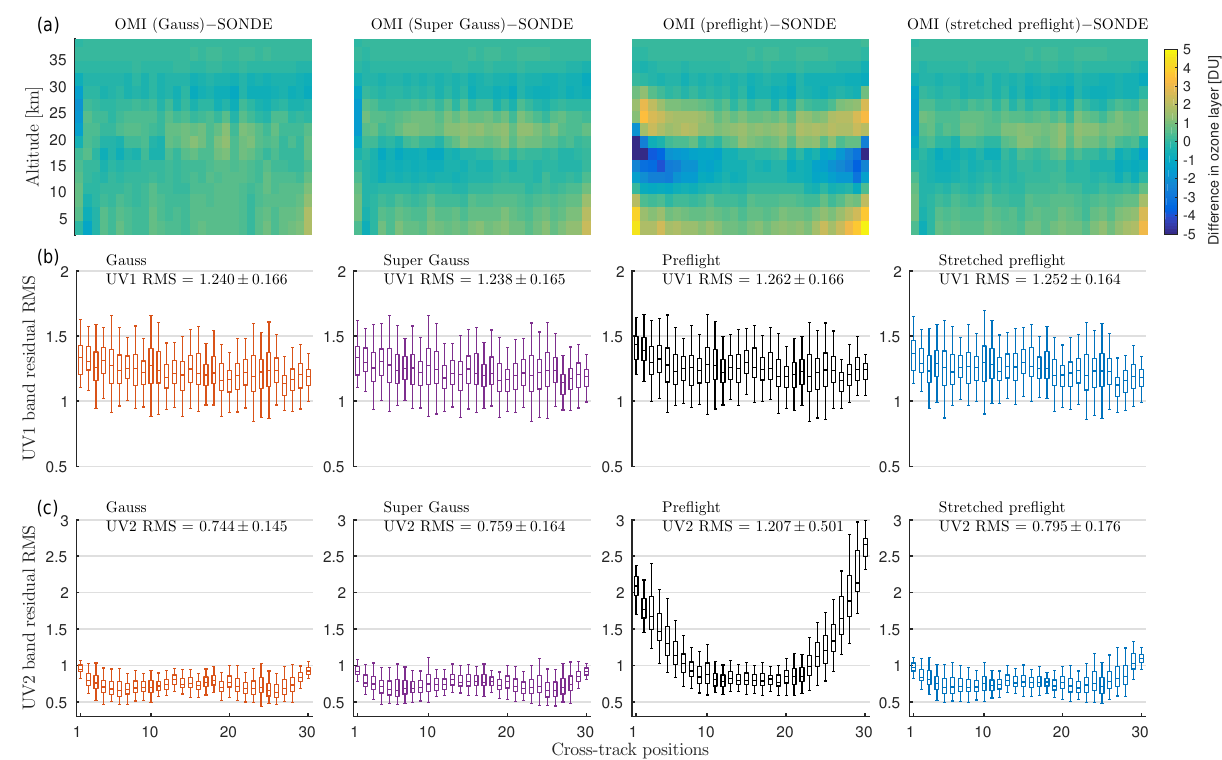
Figure 11. (a) Medians of difference profiles between OMI and ozonesondes at each cross-track position. (b) Distributions of fitting residual RMS at each cross-track position for the UV1 band. (c) Same as the second row but for the UV2 band. The mean and standard derivation of all residual RMS are labeled in each subplot at ( b and c ).